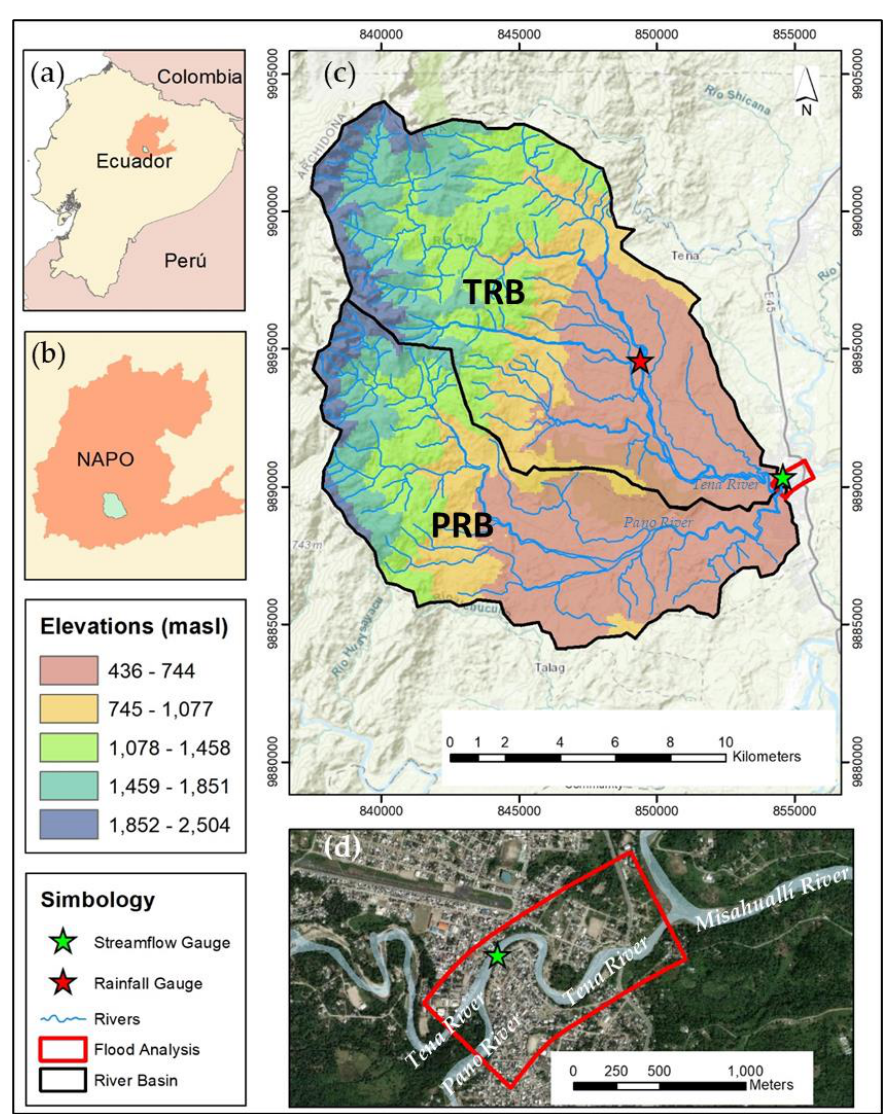
Figure 1. General features of the study area. ( a ) Location of the Napo province in Ecuador; ( b ) study area within the Napo province; ( c ) terrain elevation and location of the precipitation and streamflow gauges; ( d ) domain used for flood hazard assessment (red polygon) in the city of Tena.